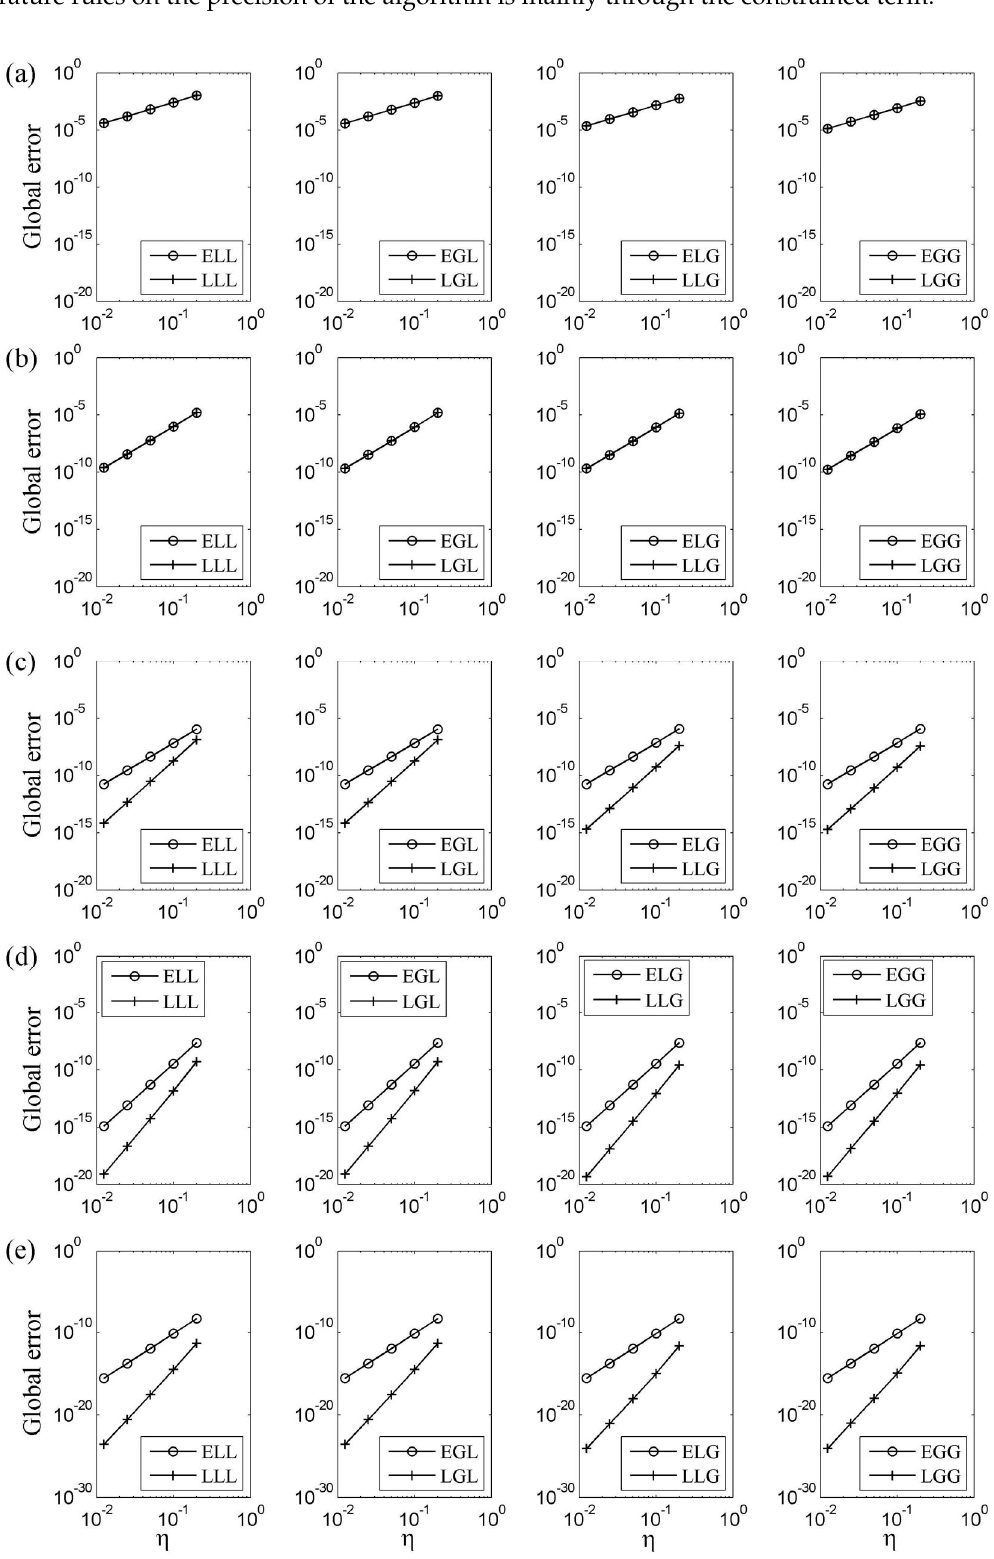
Figure 2. Nonlinear spring pendulum: Log-log plot of the global error of Hamiltonian during 0 ∼ 400 s with ( a – e ) corresponding to m = 2, 3, ··· , 6, respectively.